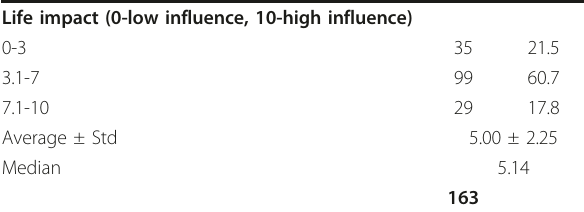
Table 3 Pain influence on daily routine (scale of